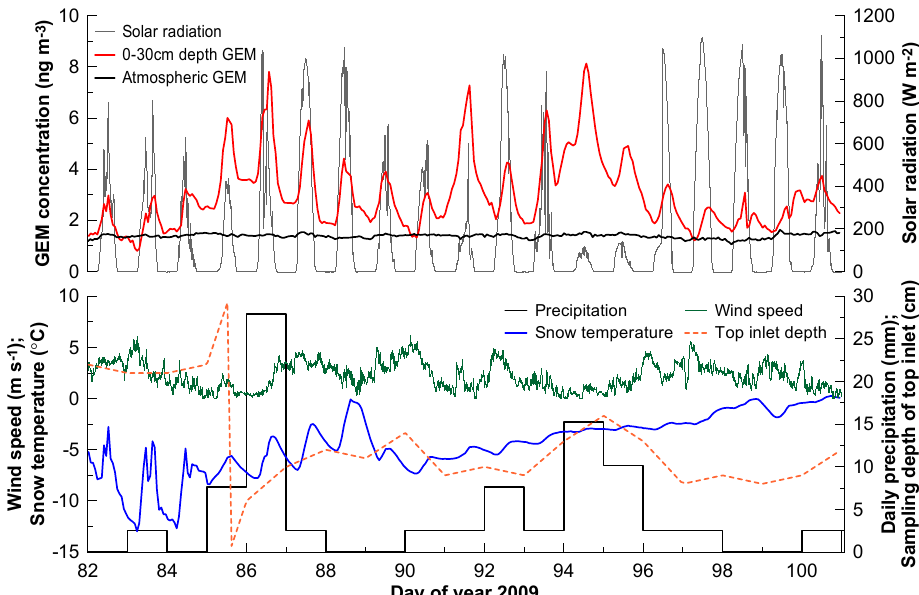
Fig. 4. GEM concentration in the snow interstitial air measured in the 0–30cm depth top snow layer from day of year 82 to 102 (red line). During this period, the depth of this inlet decreased from ∼ 22cm to ∼ 13cm (dashed orange line). Atmospheric GEM (thick black line) was stable with an average value of 1.4±0.1ngm − 3 . Wind speed (green line), solar radiation (gray line), and daily precipitation (black histogram) collected at the Soddie SNOTEL station are also